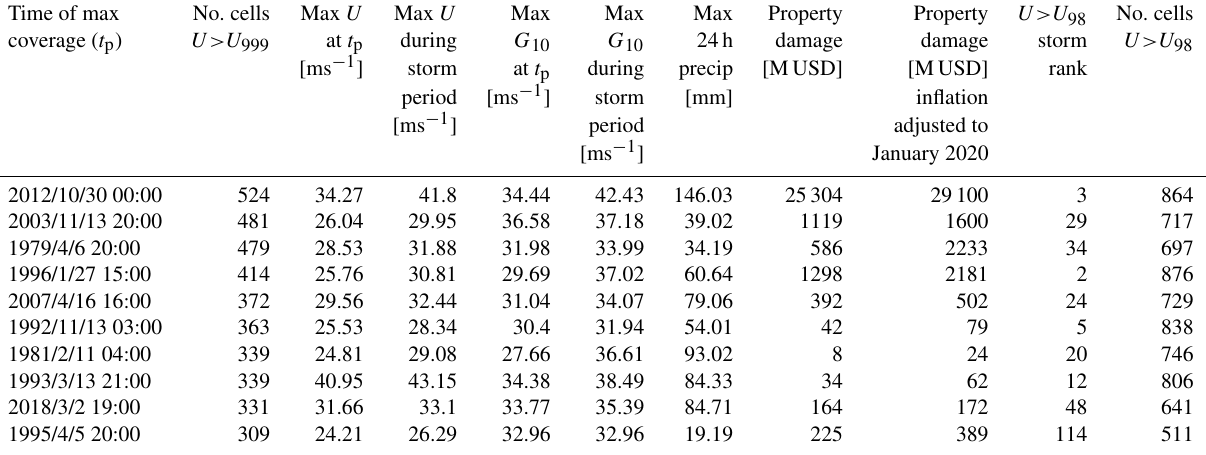
Table 2. Summary of the top 10 windstorms listed in rank order of spatial extent. The time of max coverage ( t p ) shows the time (in UTC) and date (listed as year/month/day) with the greatest geographic extent of high wind speeds. No. cells indicates the count of ERA5 grid cells (out of 924) with U>U 999 at t p . The maximum precipitation accumulated in any northeastern state land grid cell is given for the 24h surrounding the storm peak. Maximum sustained wind speeds at 100m ( U ) and wind gusts ( G 10 ) at 10m are given for the 924 northeastern state land grid cells during each storm, for both t p and the entire wind storm period (97h). Property damage for the northeastern states is based on NOAA storm damage reports and is accumulated over the duration of the period for which the associated cyclone (defined using RV) is evident. Inflation adjusted property damage is derived using inflation estimates from the US Bureau of Statistics (https://www.bls. gov/data/inflation_calculator.htm, last access: 2 June 2021). For comparative purposes, results from an analysis using a 98th-percentile wind speed threshold are shown in the final two columns. U>U 98 storm rank denotes the rank of windstorms defined using that local threshold, and no. cells U>U 98 indicates the number of NE grid cells that exceed their local 98th-percentile value. Time of max No.